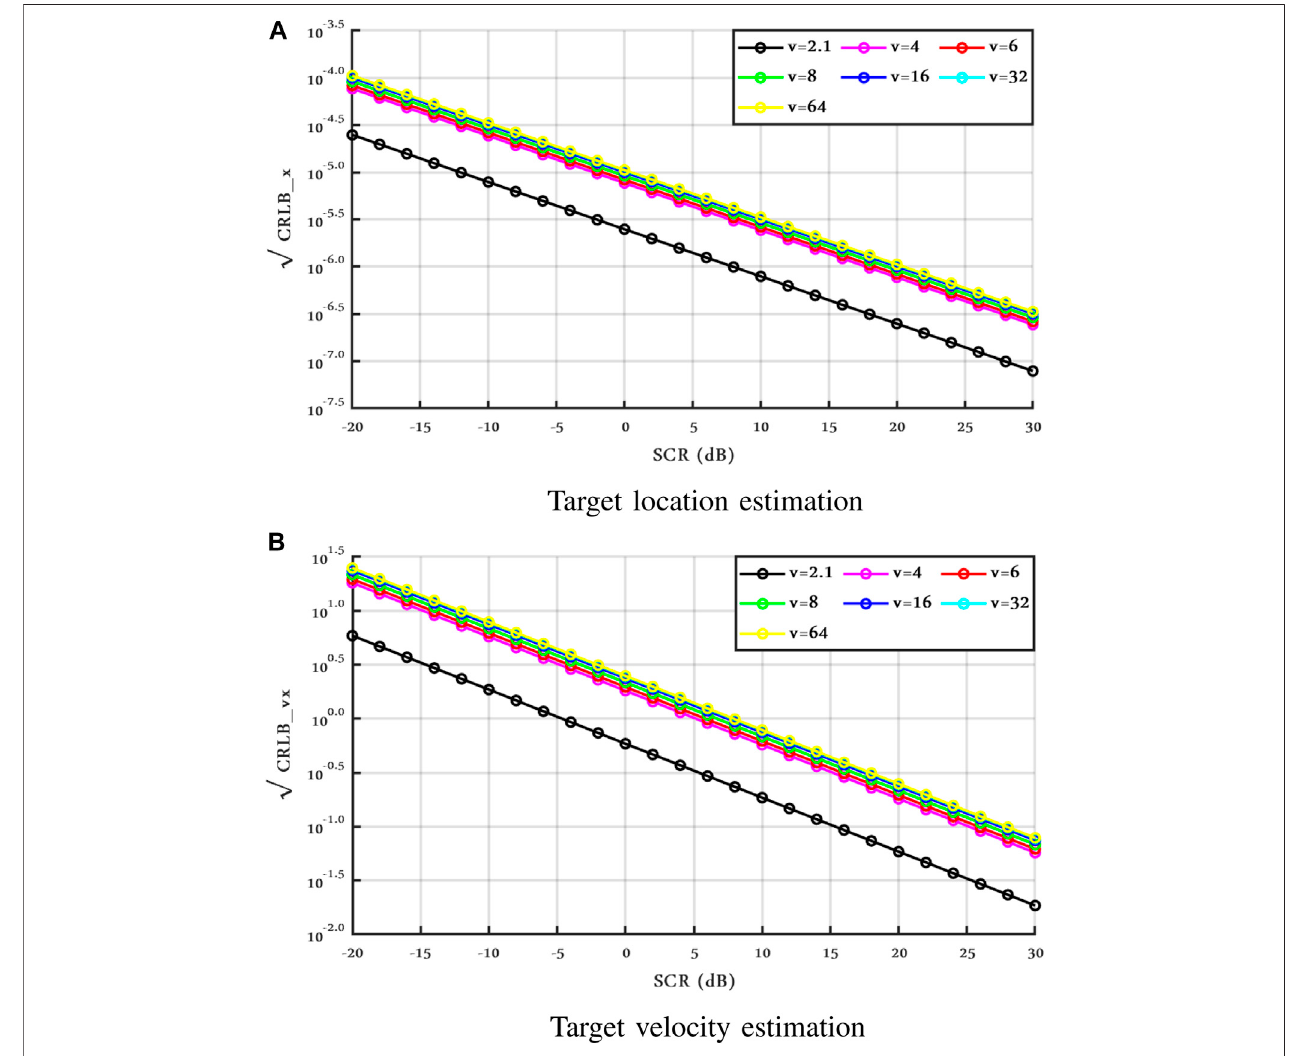
FIGURE 5 | CRLBs vs. SCR with different ] , Clutter Model